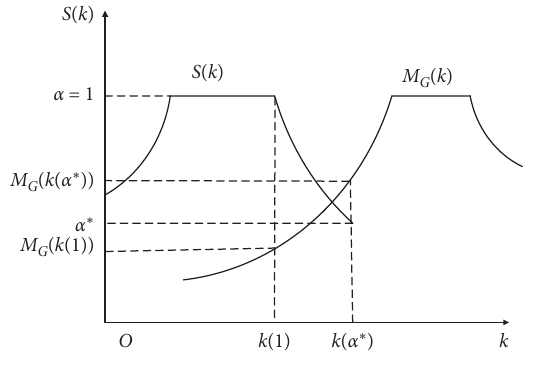
Figure 6: Absolutely optimal